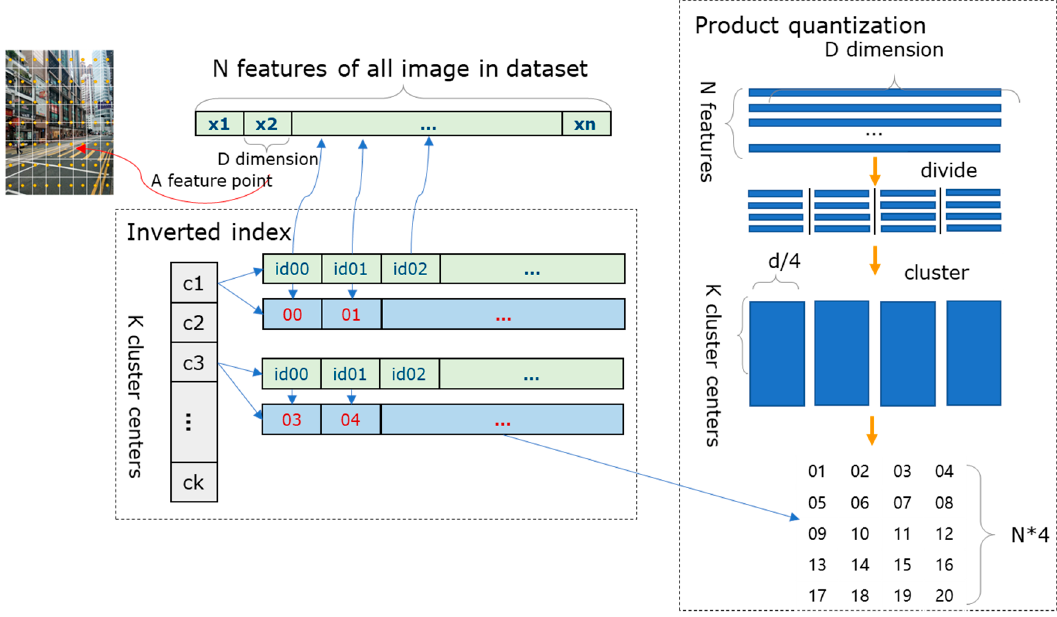
Figure 5. The process of the inverted index and product quantization.